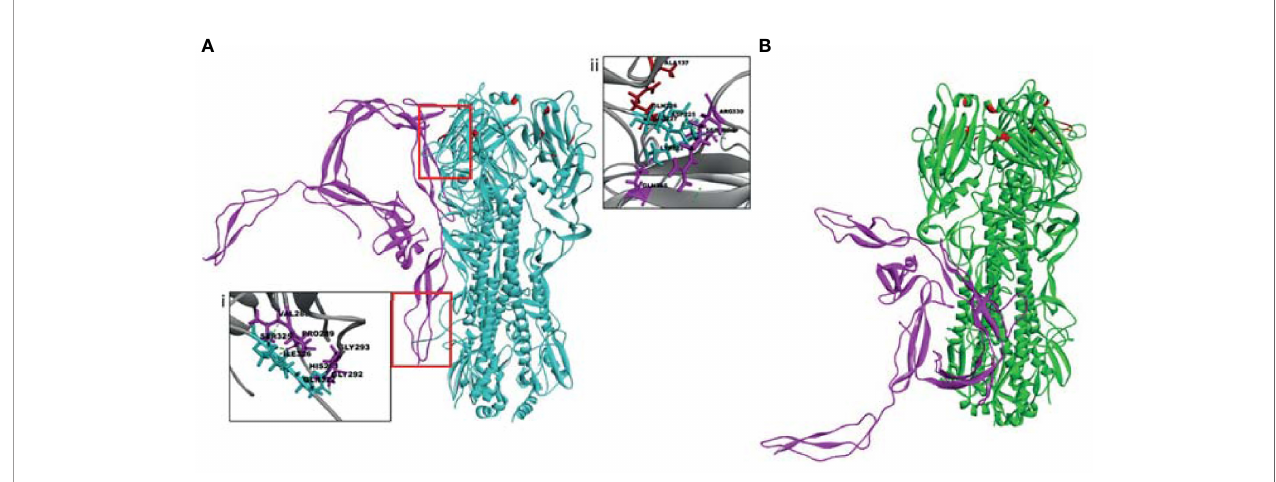
FIGURE 9 | The top docked poses indicate that human properdin (pink) binds to the sialic acid-binding site (upper red box) and cleavage site (lower red box) of HA of (A) H1N1 and not of (B) H3N2. Docking of human properdin to HA receptors of H1N1 and H3N2 was performed using the Z-Dock algorithm. The lowest energy pose from the top 10 clusters was selected as the top pose. Intermolecular interactions between receptor (HA) and ligand (Properdin) (< 10 Å distance) were analysed. Hydrogen bonds (dotted line) between HA of H1N1 and properdin at the cleavage site is shown in the inset (i) between receptor-ligand residues SER325 - VAL288, ILE326 - PRO289, GLN327 - GLY292, GLN327 - GLY293; and with residues SER325, ARG330 proximal to the sialic acid receptor binding site in the inset (ii). Sialic acid receptor binding site residues are depicted in red.